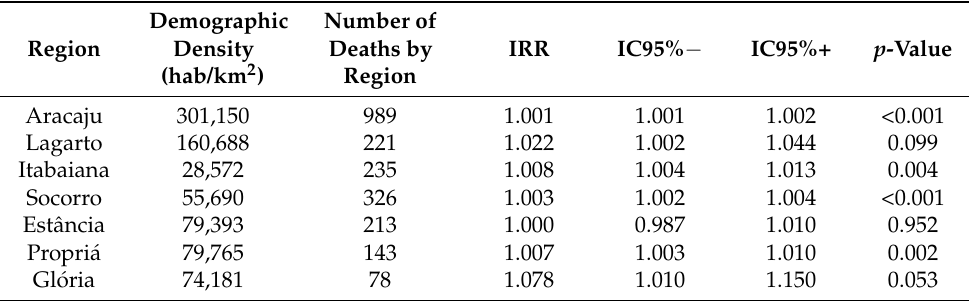
Table 2. Ratio of the incidence rate (RTI) between number of deaths by COVID-19 with demographic density of the health regions of the State of Sergipe. Period—April to October 2020.